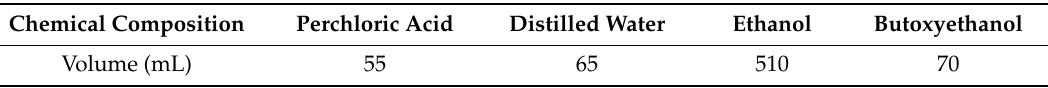
Table 2. Chemical composition of the electrolyte for electrolytic polish of electron backscatter di ff raction (EBSD) specimens.